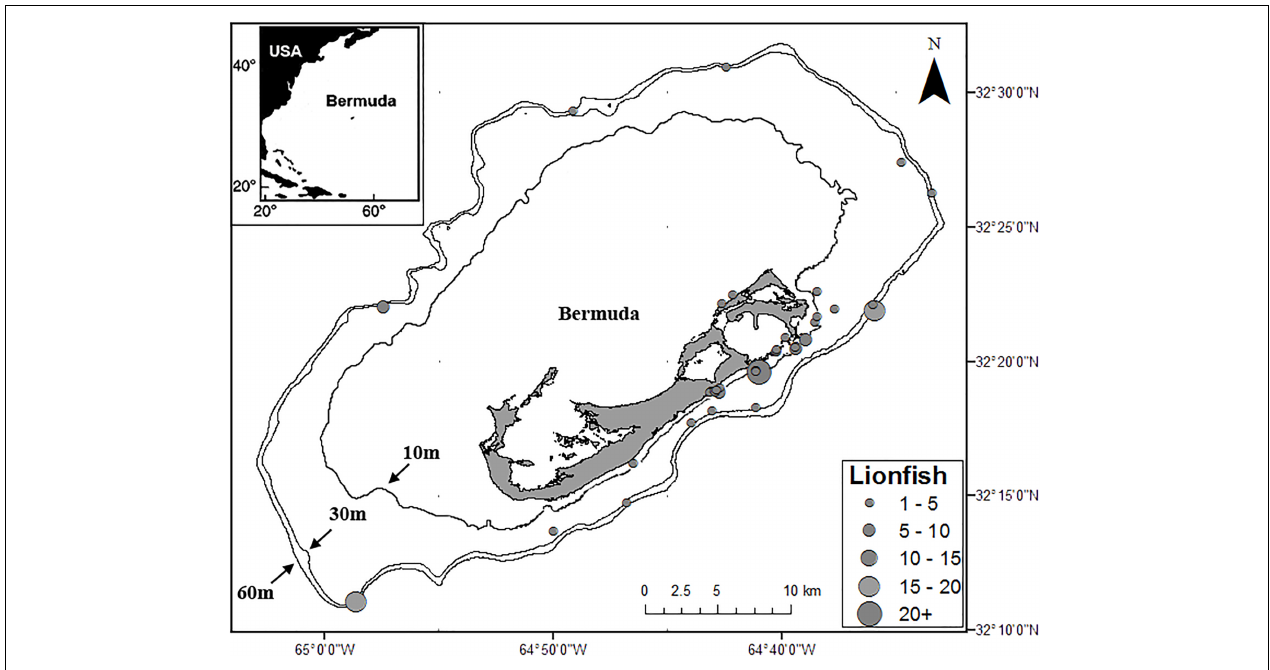
FIGURE 1 | Locations and relative numbers of lionfish captured for this study. Depth contour lines at 10, 30, and 60 m are also